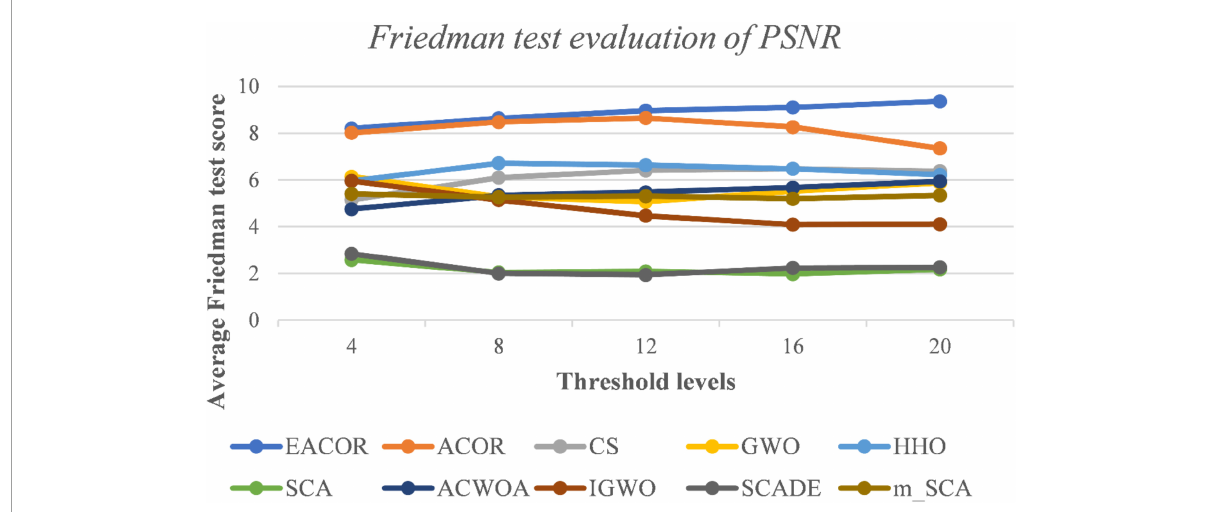
FIGURE17 FT result of PSNR evaluation at different thresholds for nine melanoma images.